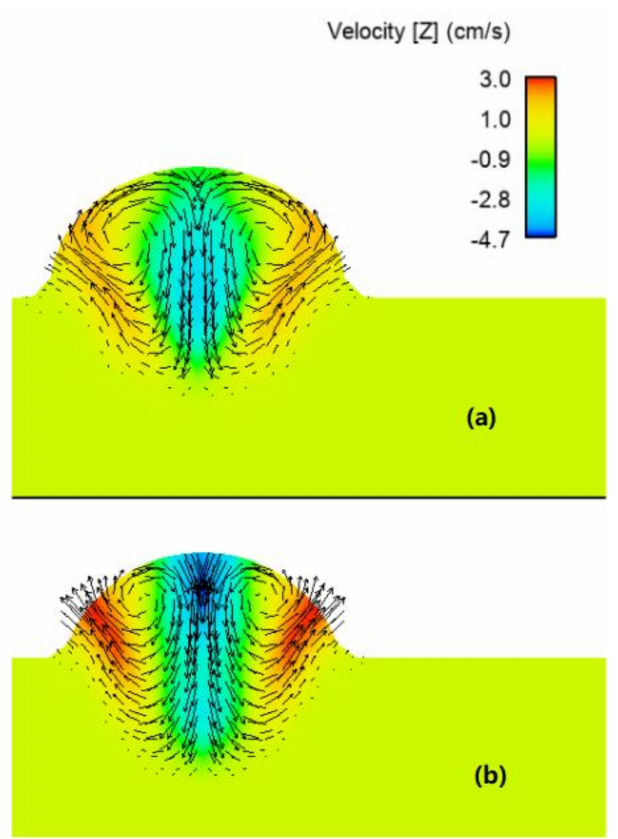
Figure 18. Velocity comparison for ( a ) a 500 ppm oxygen concentration with low heat flux, represent- ing the binary blend and ( b ) a 420 ppm oxygen concentration with high heat flux, representing the ternary